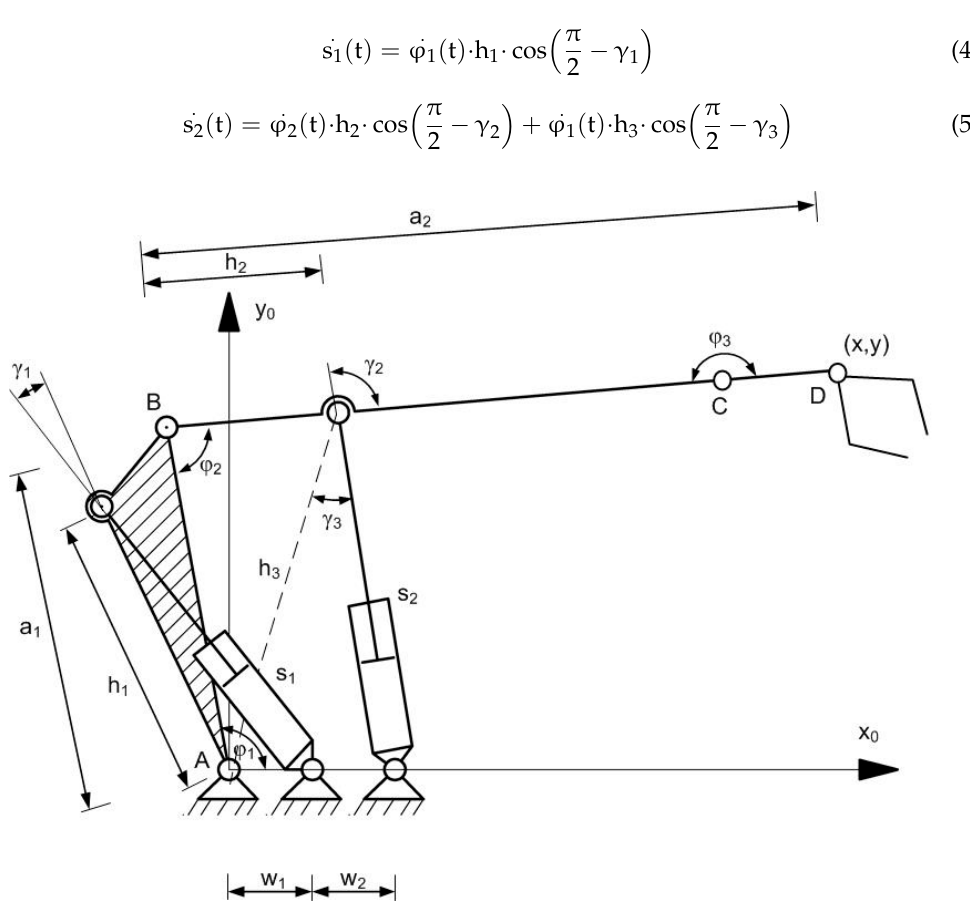
Figure 8. Kinematic structure of the tested manipulator. Table 2. Main dimensions of the tested manipulator.